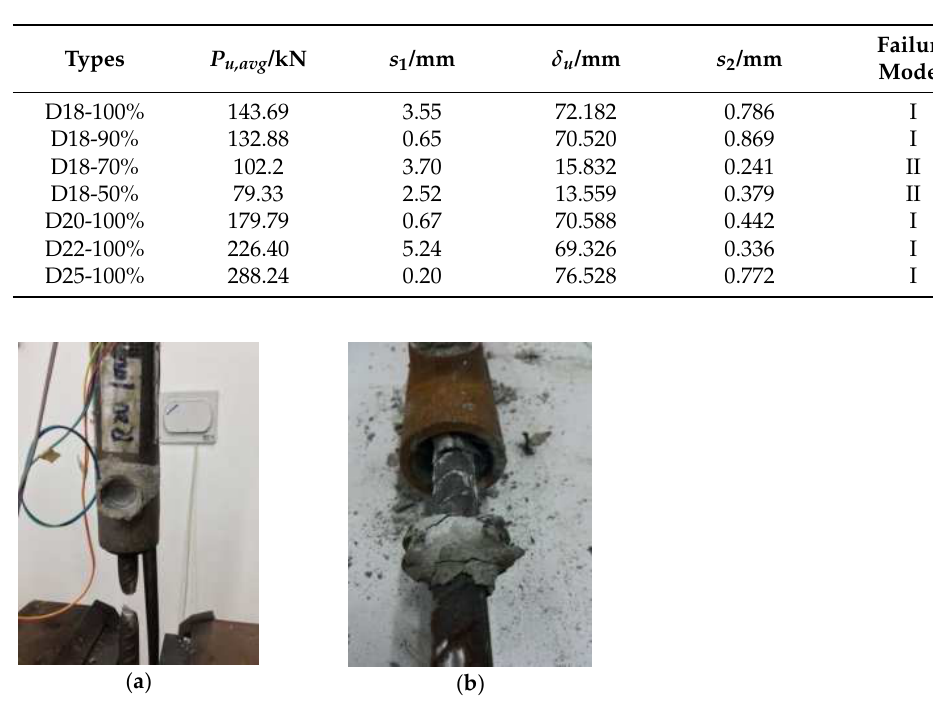
Figure 6. Typical failure modes of the GSS connectors. ( a ) Rebar rupture failure. ( b ) Bond-slip failure of rebar-grout.